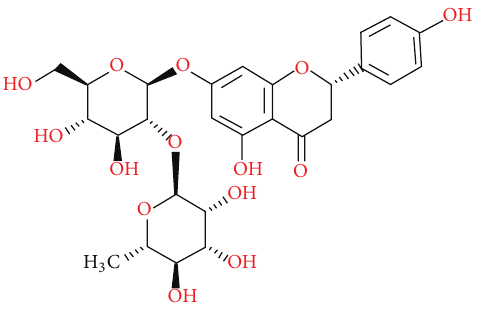
Figure 1: The chemical structure of